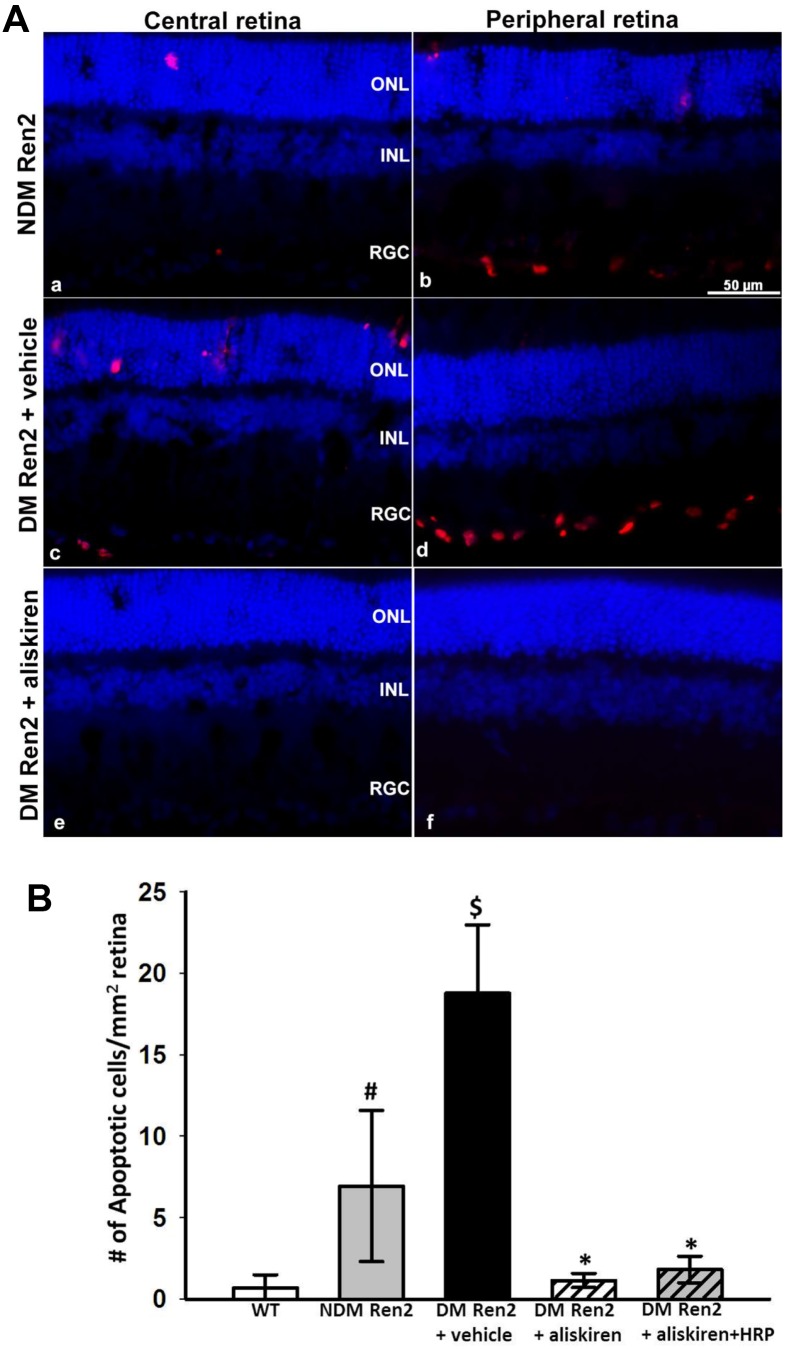
In situ cell death detection in the retina.A, Apoptotic cells were detected in-diabetic (NDM) Ren2 rats (a & b), diabetic (DM) Ren2 rats treated with vehicle (c & d), and aliskiren (e & f). ONL: outer nuclear layer; INL: inner nuclear layer; RGC: retinal ganglion cell layer. B, Quantitative measurement of apoptotic cells detected by TUNEL assay. #p<0.01 (vs. wildtype (WT) Sprague–Dawley rats); $p<0.01 (vs. NDM Ren2 and WT); *p<0.01 (vs. NDM Ren2 and DM Ren2+ vehicle).